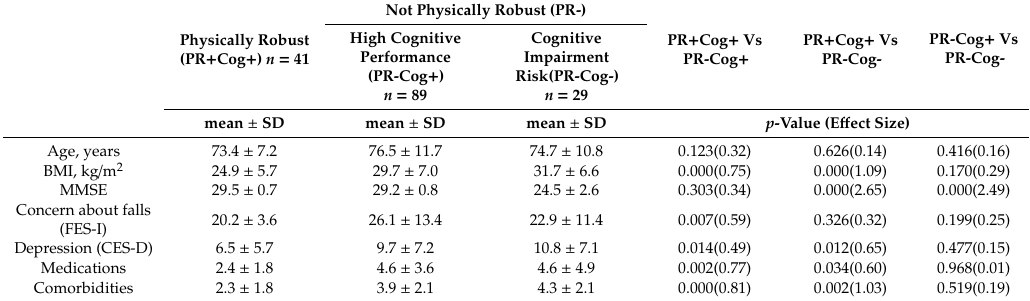
Table 1. Demographic and clinical characteristics reported by mean ± standard